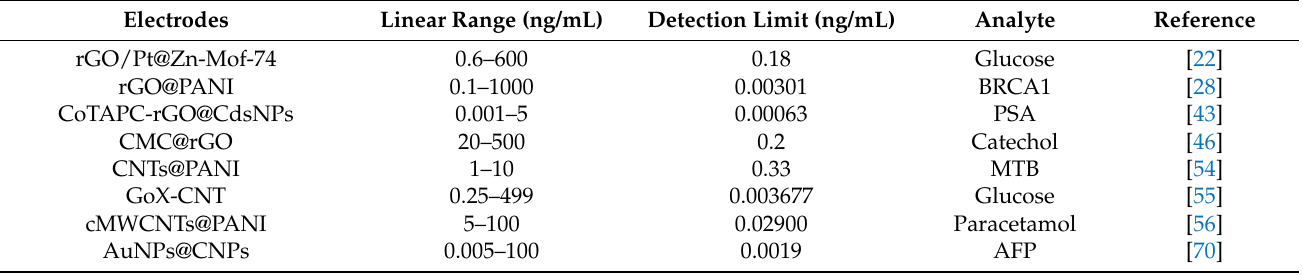
Table 2. Reveals the summary of various carbon nanomaterials used in the development of biosensors for various